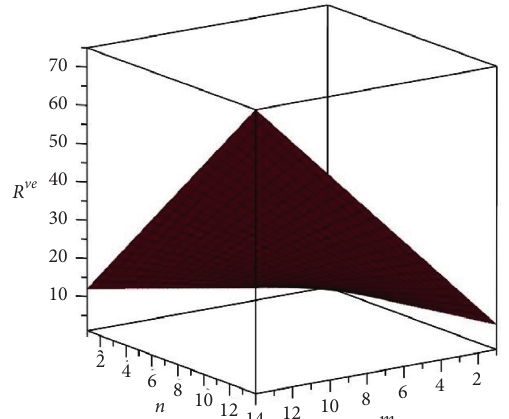
Figure 6: Graphical representation of R ve ( VC [ m, n ])